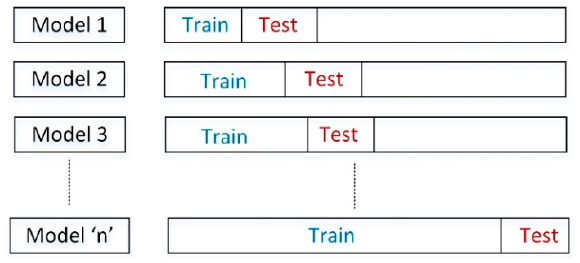
Figure 16. Time Series Split for Model Figure 16 . Time Series Split for Model Validation. Figure 16 . Time Series Split for Model Validation.